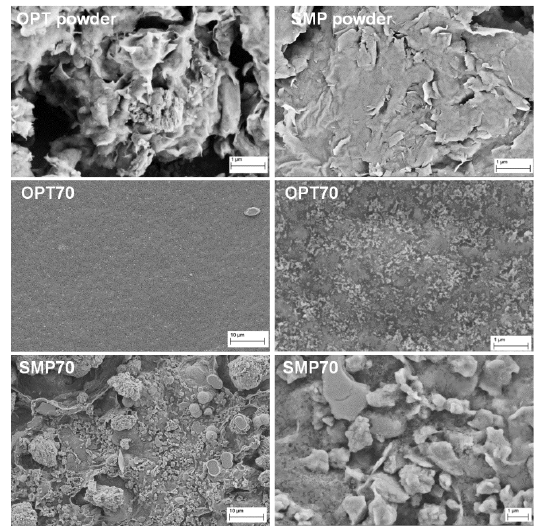
Figure 1. SEM micrographs of the food-grade activated montmorillonite (Optigel, OPT) and high-purity unmodified montmorillonite (SMP) powders, and the OPT- and SMP-based films. Table 2. Thermal properties of the chitosan and nanoclay-based supports.